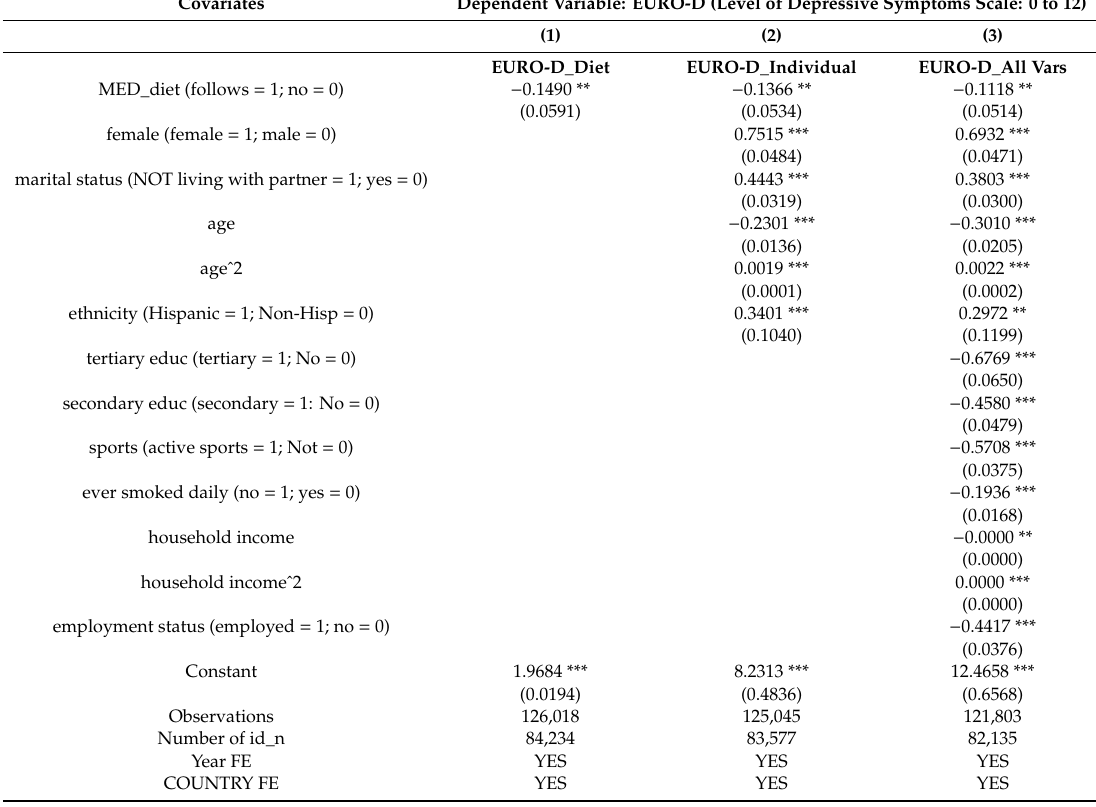
Table 4. Regression analysis relating levels of depressive symptoms with the Mediterranean diet, individual and socio-demographic characteristics and lifestyle